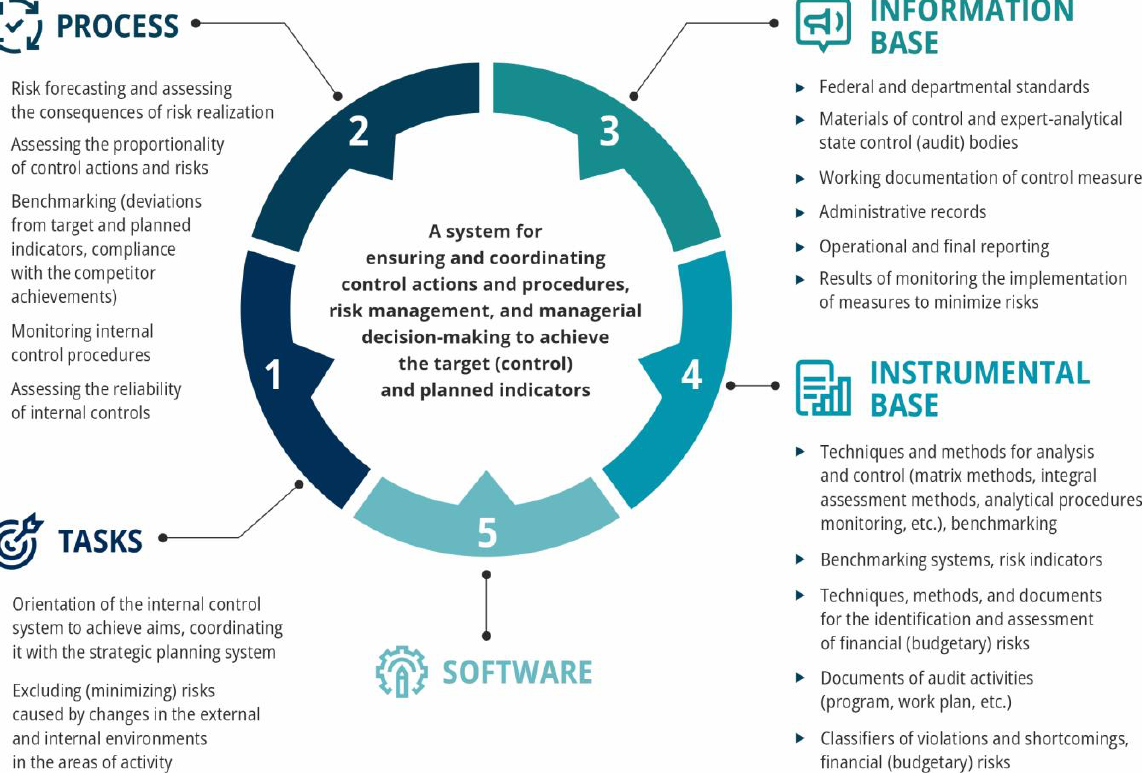
Figure 4.Controlling in the field of internal control over the state bodies and organizations’